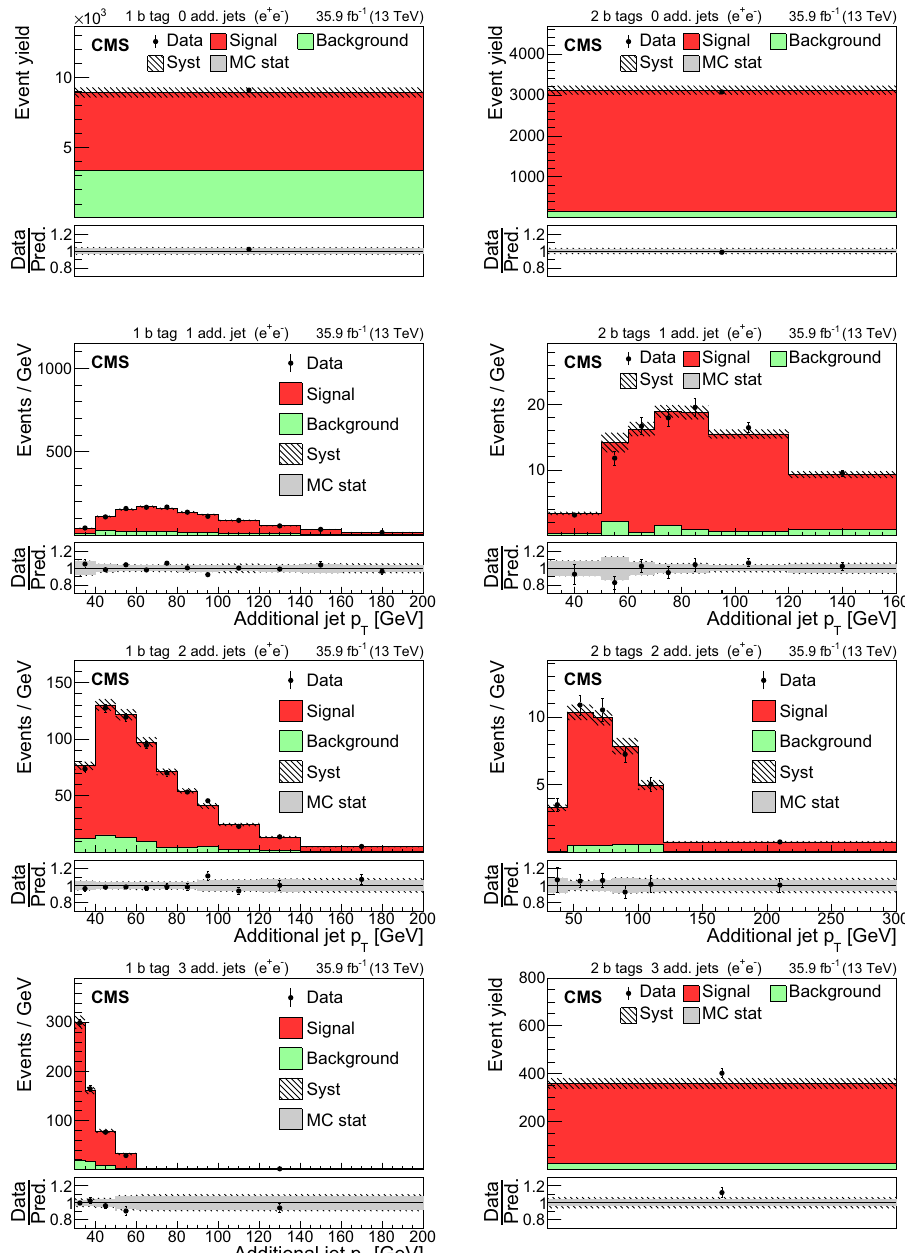
Fig. 6 Same distributions as in Fig. 5, but in the e + e −